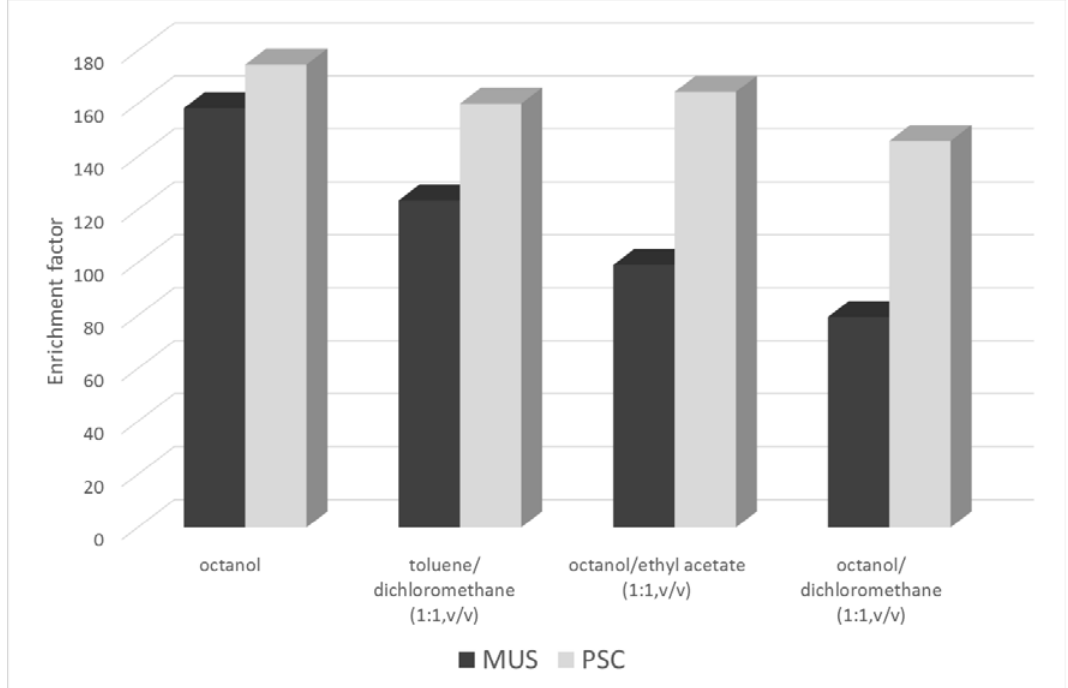
Figure 1. Effect of organic solvent on the enrichment factor of the studied analytes in aqueous samples using the SDME-CE system. Sample concentration: 25 mg L −1 , pH 4; CE conditions: BGE—25 mM using the SDME-CE system. Sample concentration: 25 mg L − 1 , pH 4; CE conditions: BGE—25 mM phosphate buffer pH 3; Sample volume: 200 µL; Organic phase: various organic solvents; extraction phosphate bu ff er pH 3; Sample volume: 200 µ L; Organic phase: various organic solvents; extraction time: 180 s; injection: 0.1 psi, 1s; n = 6, RSD < 6.2%. time: 180 s; injection: 0.1 psi, 1s; n = 6, RSD <